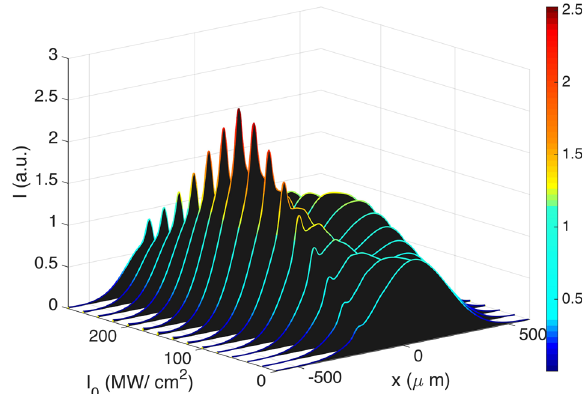
Fig. 6 Numerically simulated sections of the fundamental frequency (FF) component of the twin spotlight beam (TSB) vs. the input intensity I0. The images have been collected after propagation of 30 mm. The color bar relates to the light peak intensity (normalized with the encircling